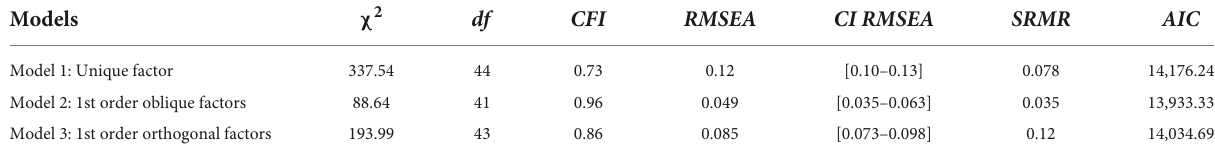
TABLE 1 Fit indices for the confirmatory factor analysis (CFA) of the self-efficacy in managing positive affect (SEMPA) in the Spanish sample. Models